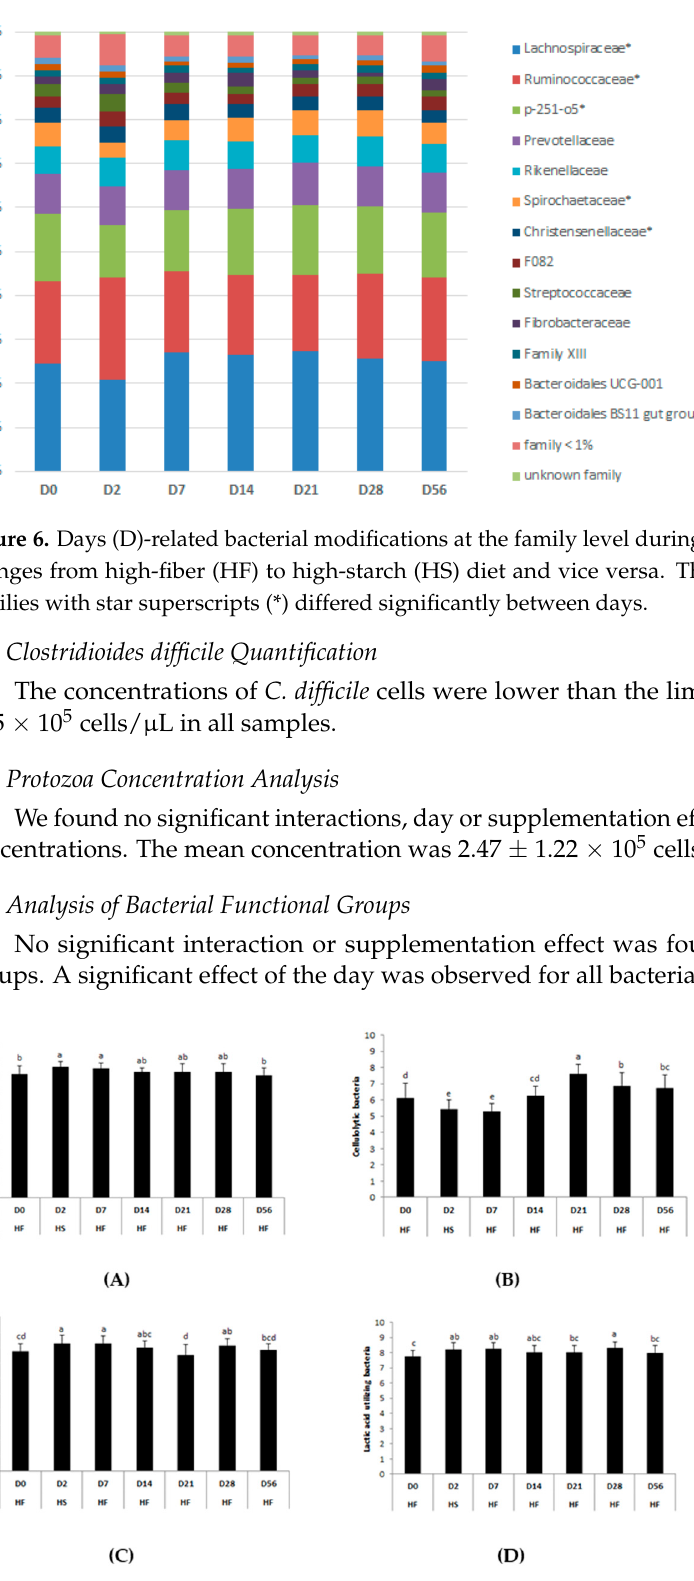
Figure 7. Days–related modifications of the bacterial functional groups’ ( A ) total anaerobes, ( B ) cellulolytics, ( C ) amylolytics, and ( D ) lactic acid utilizing during two consecutive dietary changes from high-fiber (HF) to high-starch (HS) diet and vice versa. Bacterial concentrations are expressed in log10 colony forming units /g feces. For each plot, means with different superscripts (a, b, c, d) differ at p < 0.05 for each day. Error bars are based on standard deviations for each day (D).